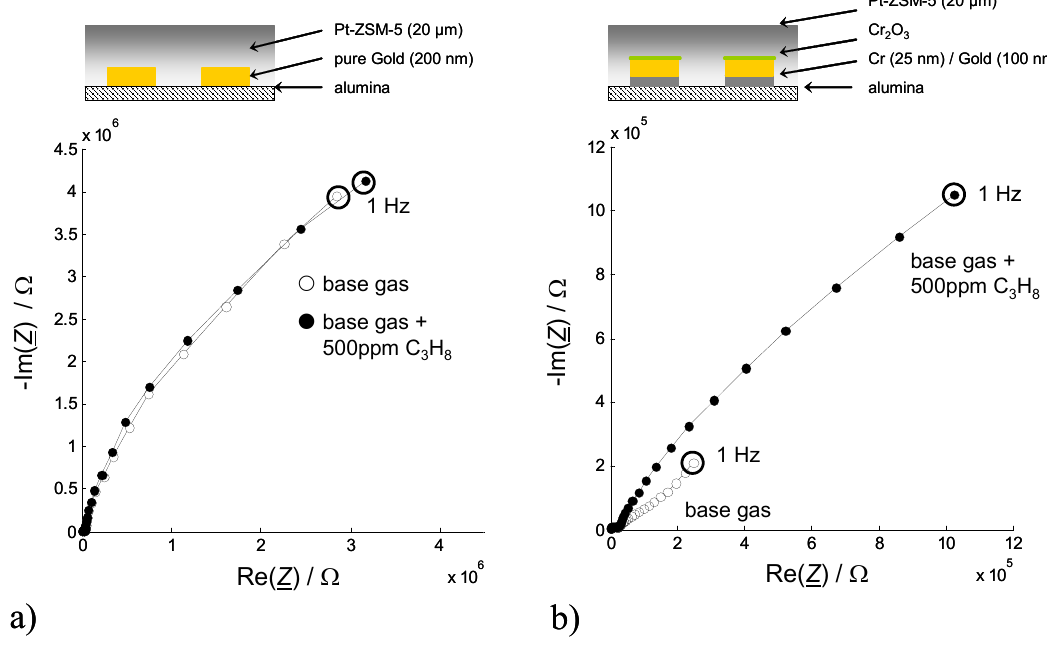
Figure 1. Impedance spectra (Nyquist Plots) and scheme of the setup of Pt-ZSM-5 covered Au-IDE (a) and Au/Cr O -IDE (b) with ( • ) and without (o) 500 ppm propane in a base gas mixture of 2.5 % 2 3 H O and 10 % O in N at 300 °C. “ (cid:123) ” indicates a measurement at a frequency of 1 Hz. Please note 2 2 2 from the sensor setup that in (b) the Cr O intermediate layer is applied only on top of the electrodes. 2 3 O -covered (see cross The spaces between the fingers of the IDE are not Cr 2 3